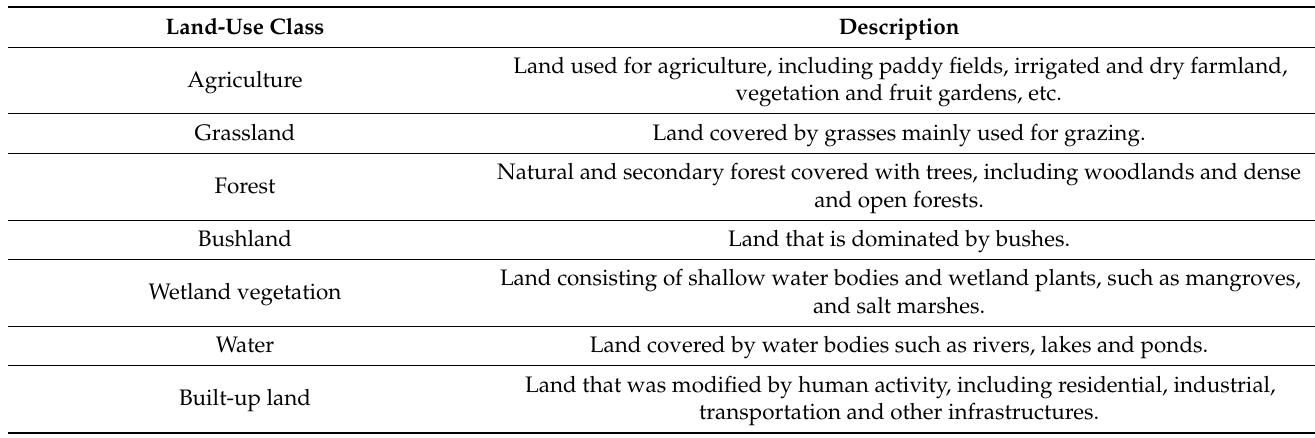
Table 1. Land-use land-cover classes used in the